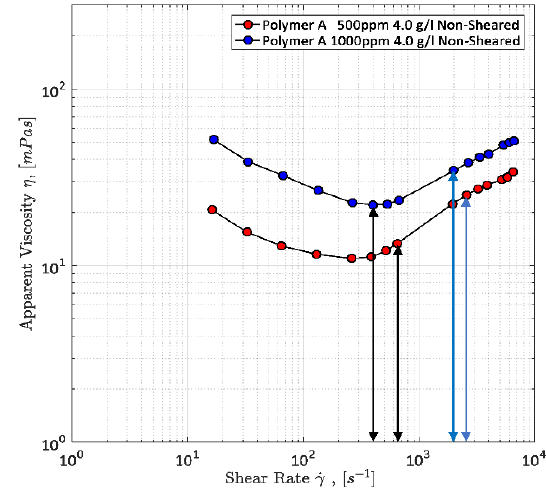
Figure 8. Apparent viscosity vs. shear rate measured in a GSG micromodel. The black lines illustrate the onset of the transitional flow pattern whereas the blue lines illustrate the onset of elastic turbulence (Rock [69]).